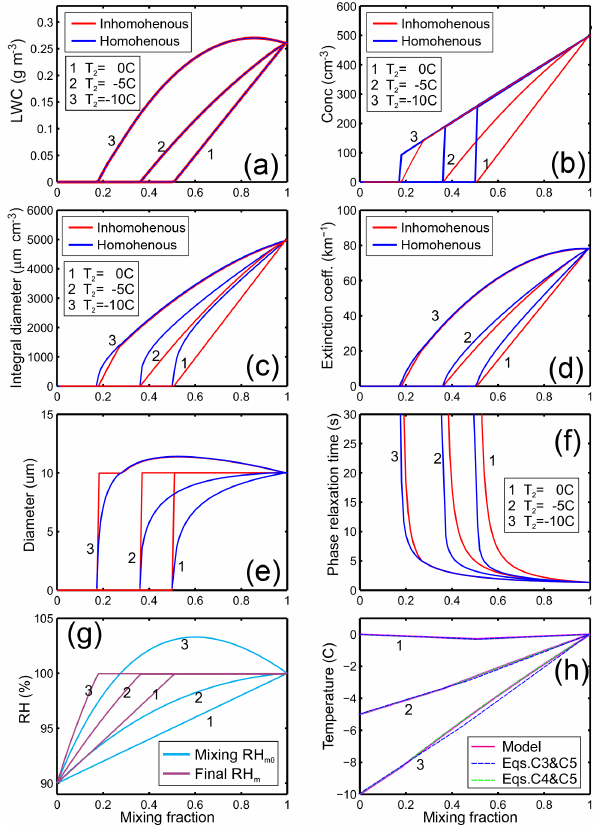
Figure 6. Simulation of (a) droplet number concentration and (b) liquid water mixing ratio, (c) integral droplet diameter, (d) ex- tinction coefficient, (e) mean volume diameter, (f) time of phase relaxation, (g) relative humidity in the mixed volume before droplet evaporation RH m0 and at the equilibrium state RH m , (h) final tem- perature T m vs. ratio of mixing µ formed after homogeneous and extreme inhomogeneous mixing between dry and cloudy parcel with monodisperse droplets. The calculations were performed for RH 2 = 0 . 9; D 1 = 10µm, N 1 = 500cm − 3 ; T 1 = 0 ◦ C; T 2 = − 10, − 5, 0 ◦ C; H = 1000m.